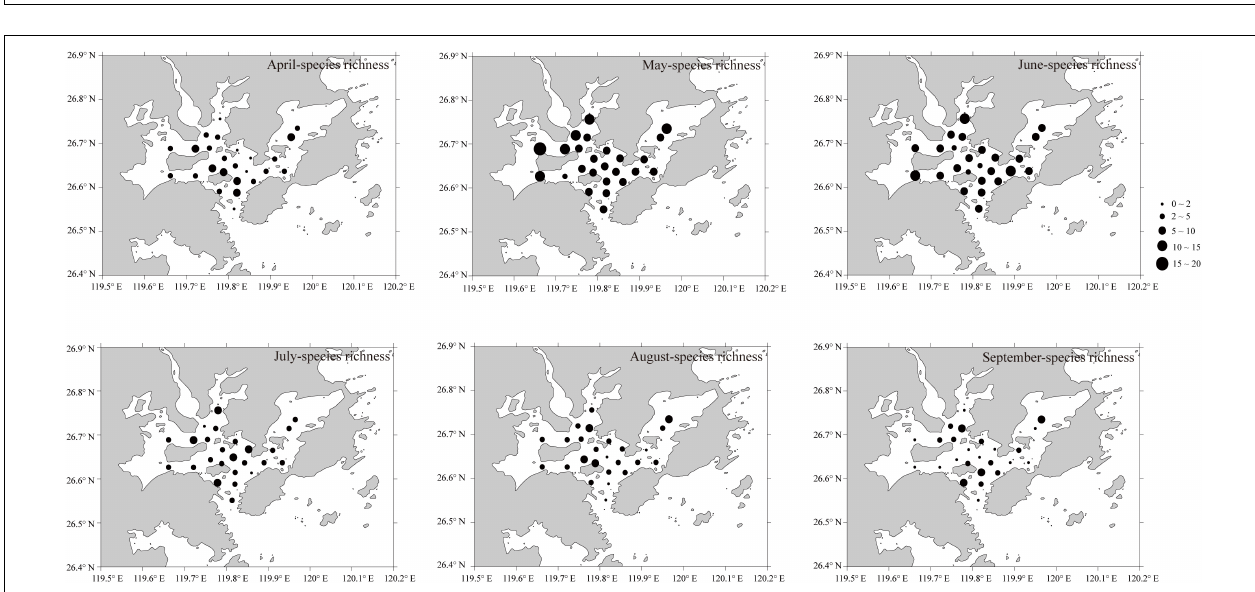
FIGURE 5 | Spatial variation of ichthyoplankton density from April to September 2019 in Sansha Bay of Fujian Province, China.